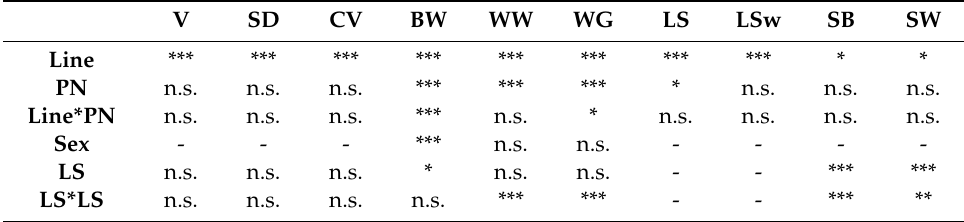
Table 3. Significance of the di ff erence between lines, parturition number, its interaction, sex, and linear and quadratic litter size covariate for the analysed traits.